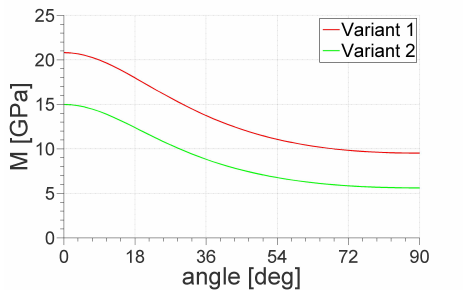
Figure 3. Angle dependency of the indentation mod- ulus.